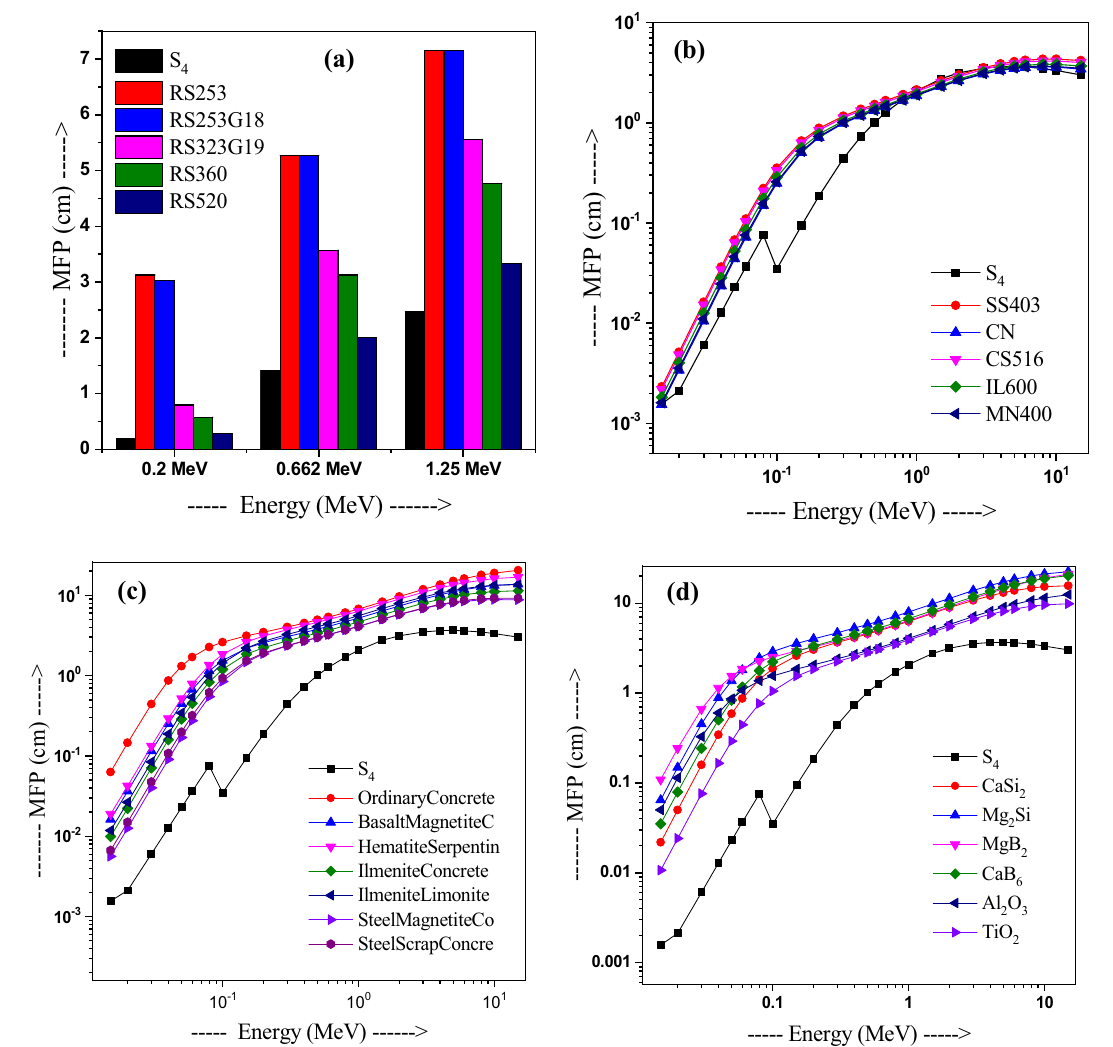
Figure 9. Comparison of MFP values of glass S4 with those in ( a ) commercial shielding glasses, ( b ) alloys, ( c ) concretes and lead, and ( d ) ceramics